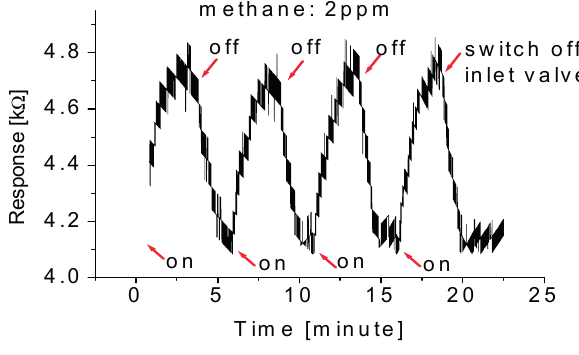
Figure 5. Typical response at room temperature when the nanowire array-based gas sensor is cycled between the “switch-on” and “switch-off” of exposure to the methane gas with a gas concentration of 2 ppm.